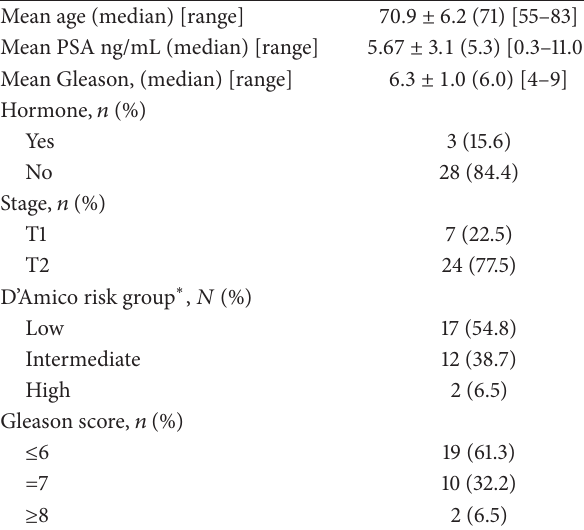
Table 3: Adverse